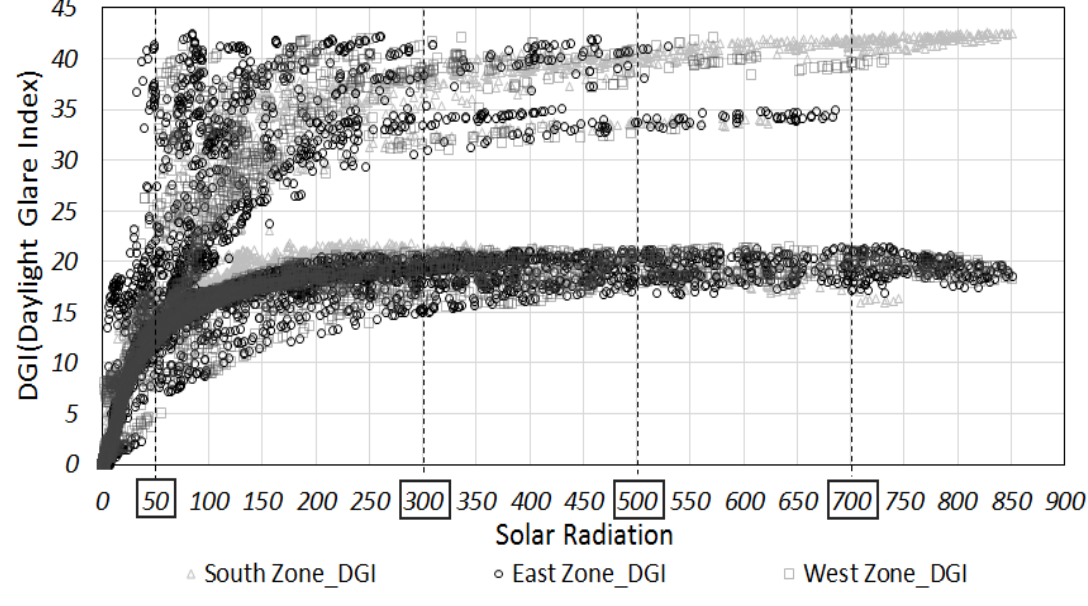
Figure 7. DGI scatterplot of solar radiation on a glass surface.